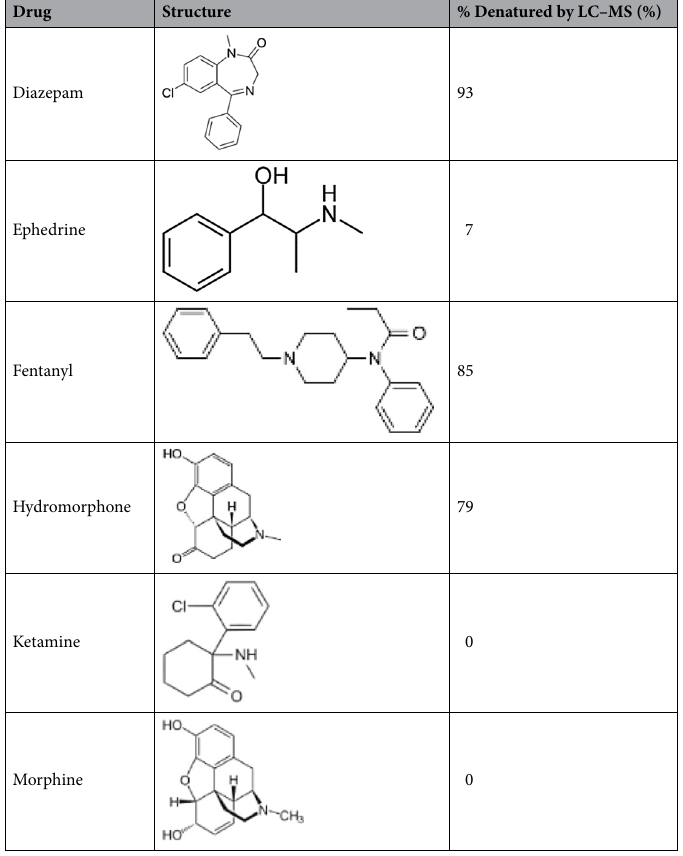
Table 4. Results for waste stream samples treated with activated charcoal. Waste stream samples were treated with water or activated charcoal for 24 h. Medications in the samples were extracted with methanol and analyzed with LC–MS. Peak areas were compared between control (water) and experimental (activated charcoal) conditions to calculate the % denatured. Denaturation was drug-specific; ketamine and morphine showed full recovery from activated charcoal, whereas diazepam was over 90%